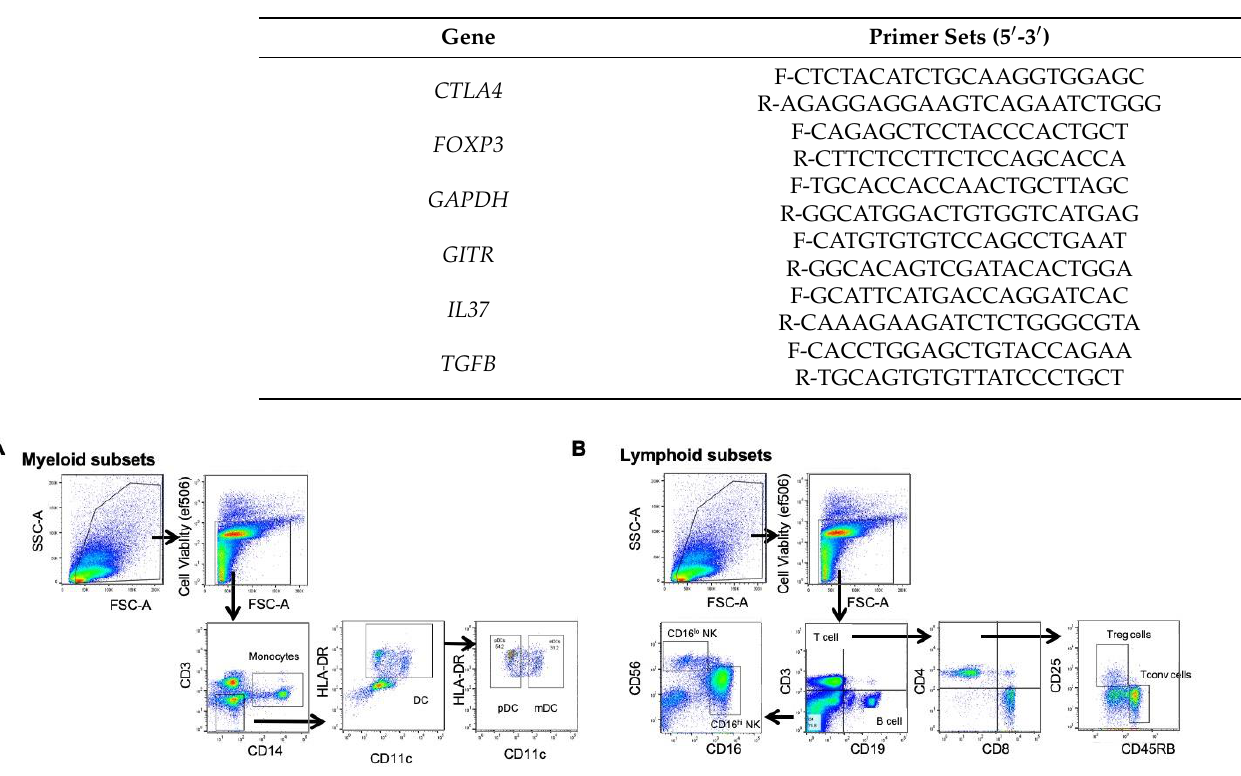
Table 1. Primer set